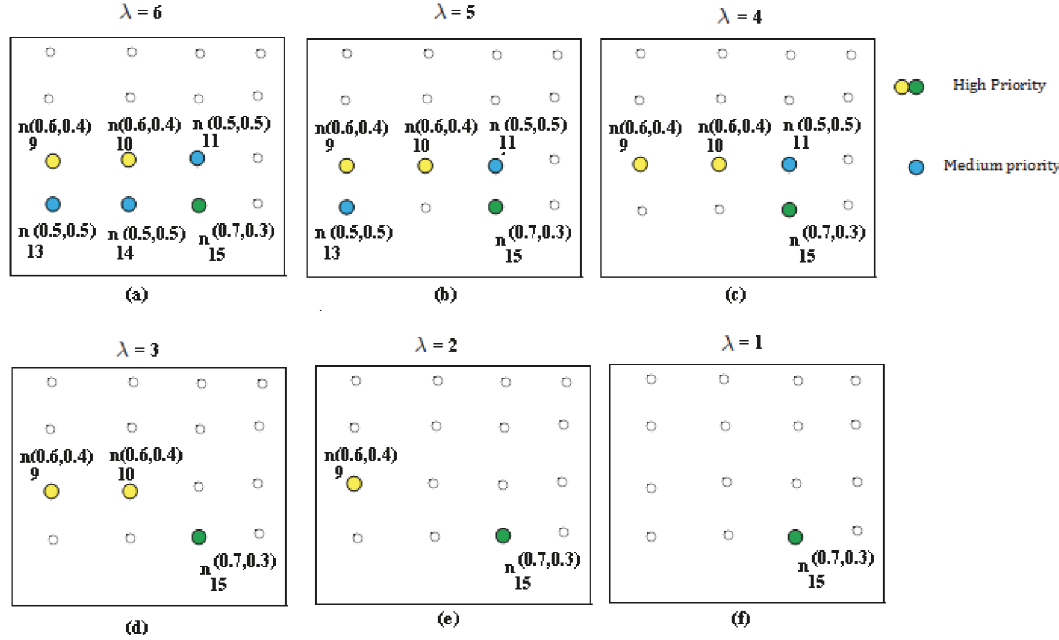
Figure 5: (a)-(f) Metric induced opening: 𝛾 𝜆 = [𝛿 𝑛 (𝜀 𝑒 (𝑌 𝑛 ))] 𝜆 for various 𝜆 .